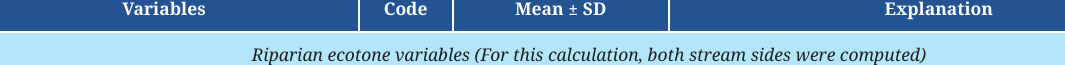
TABLE 1 | Summary of instream and riparian ecotone environmental variables, observed mean ± standard deviation, and explanation of how each variable was